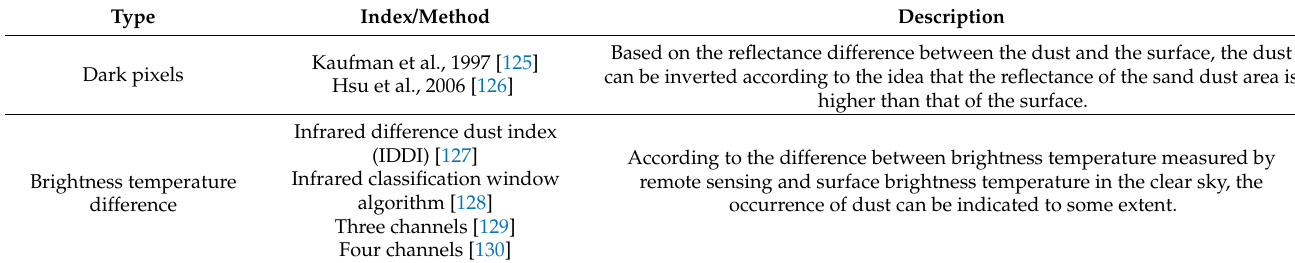
Table 8. Information extraction of dust.